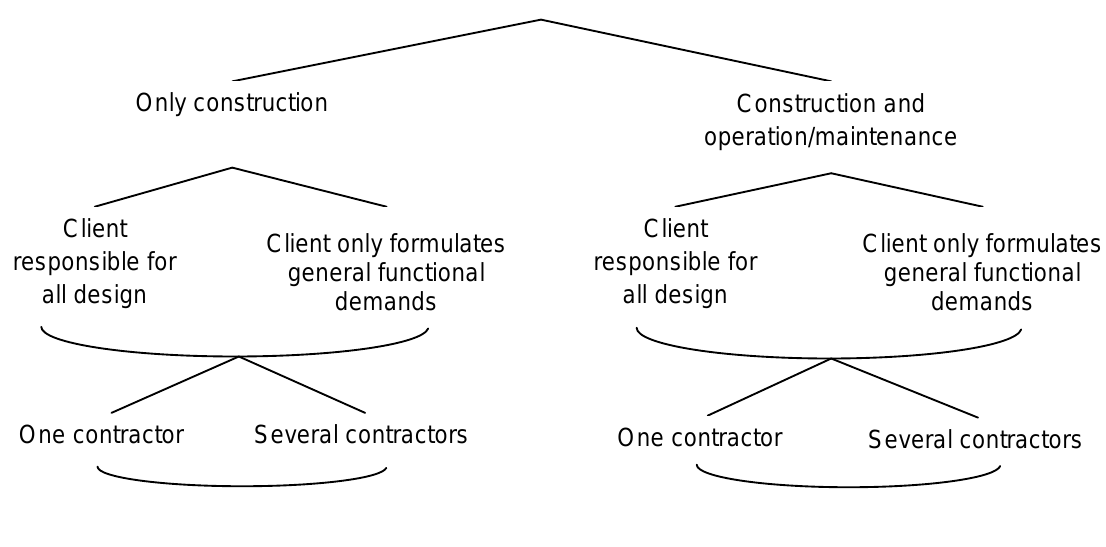
Figure 4: The complete proposed framework (Source: